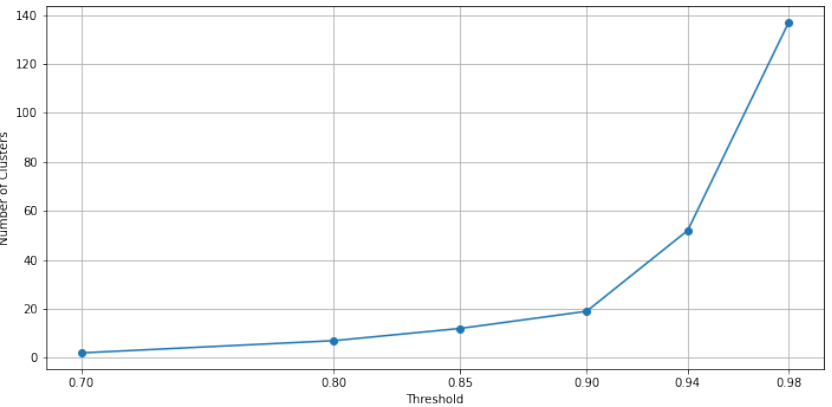
Figure 9. Graph of the number of clusters derived using the ensemble of clustering methods when the consistency threshold is